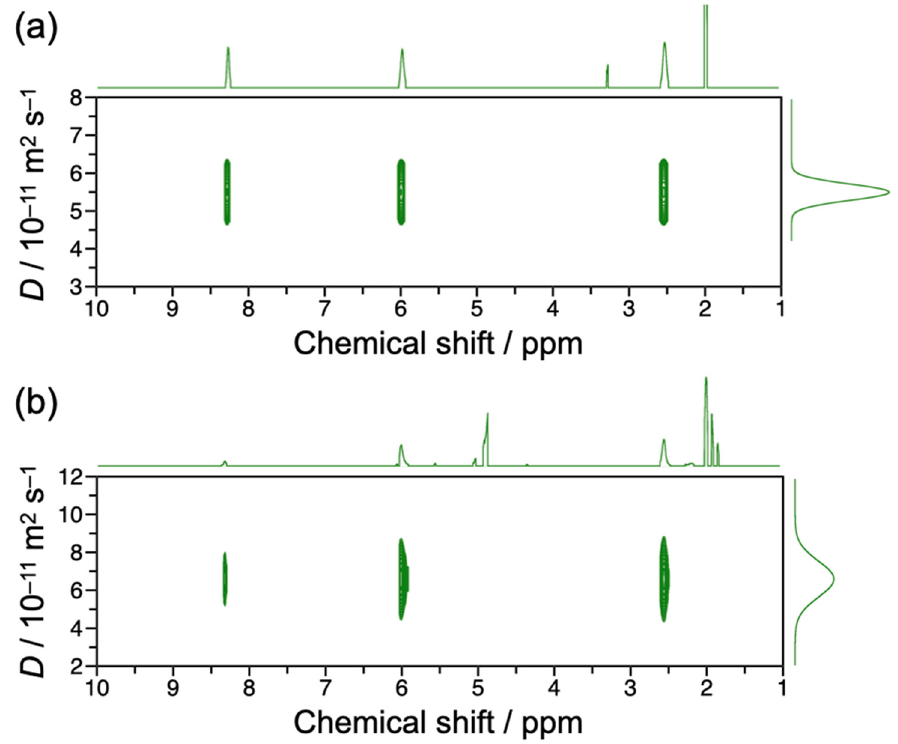
Figure 4. 2D DOSY data for poly(AH)Na in D 2 O containing 5 mM NaCl at pH 9.0 ( a ) and 12.0 ( b ).